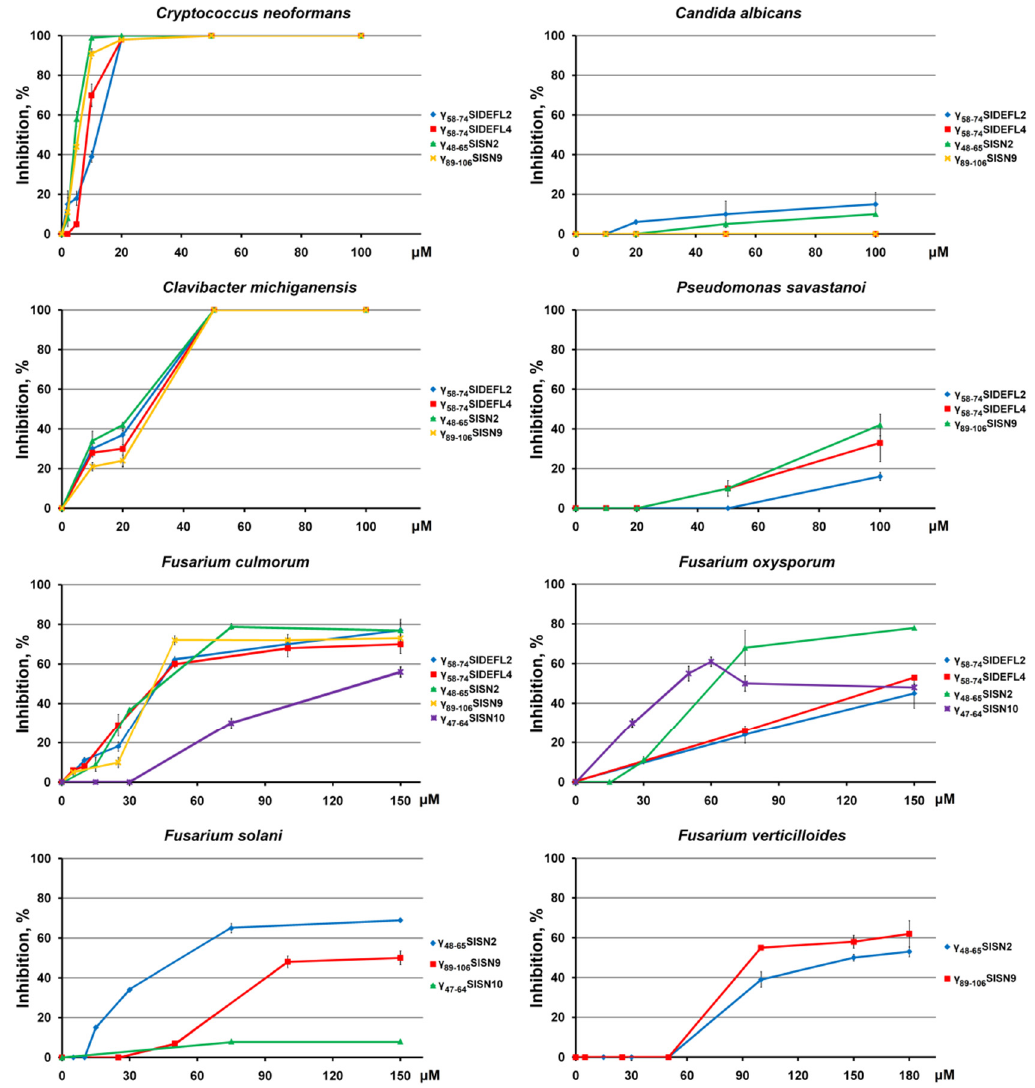
Figure 4. Inhibition curves of pathogenic microorganisms in the presence of different concentrations of tomato CRP-derived peptides (relative to control, %). Bacteria and yeasts were incubated with peptides for 24 h, and plant pathogenic fungi were treated for 38 h. Error bars represent the SD of technical triplicates. Table 2. Antimicrobial activity of synthetic peptides *.